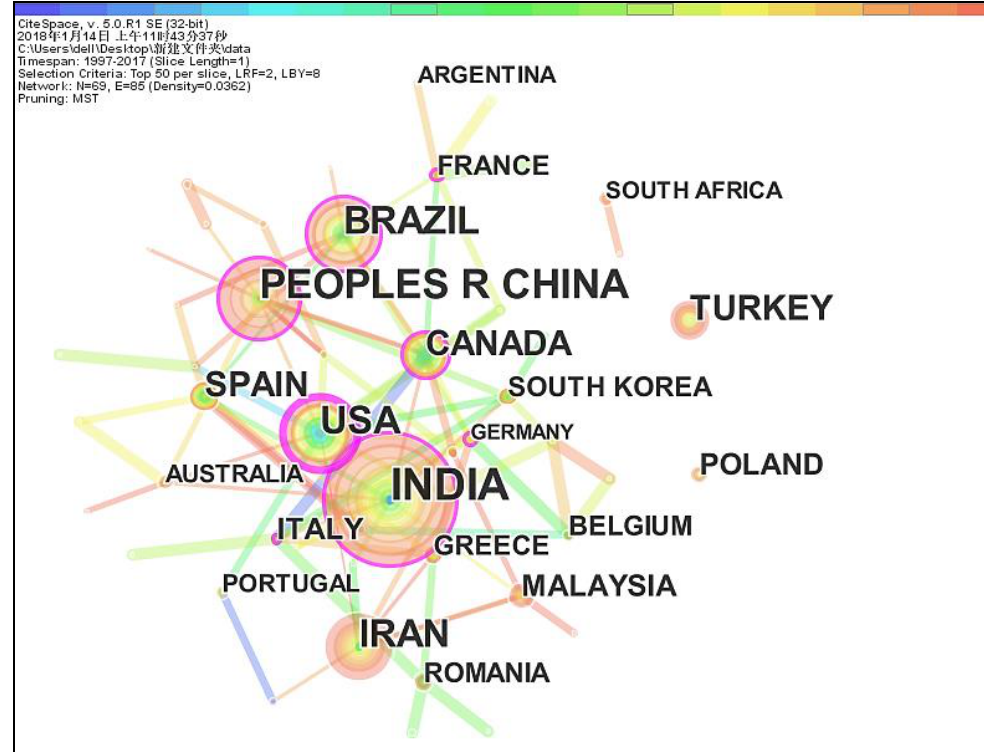
Figure 3. Research on water quality index in major countries.